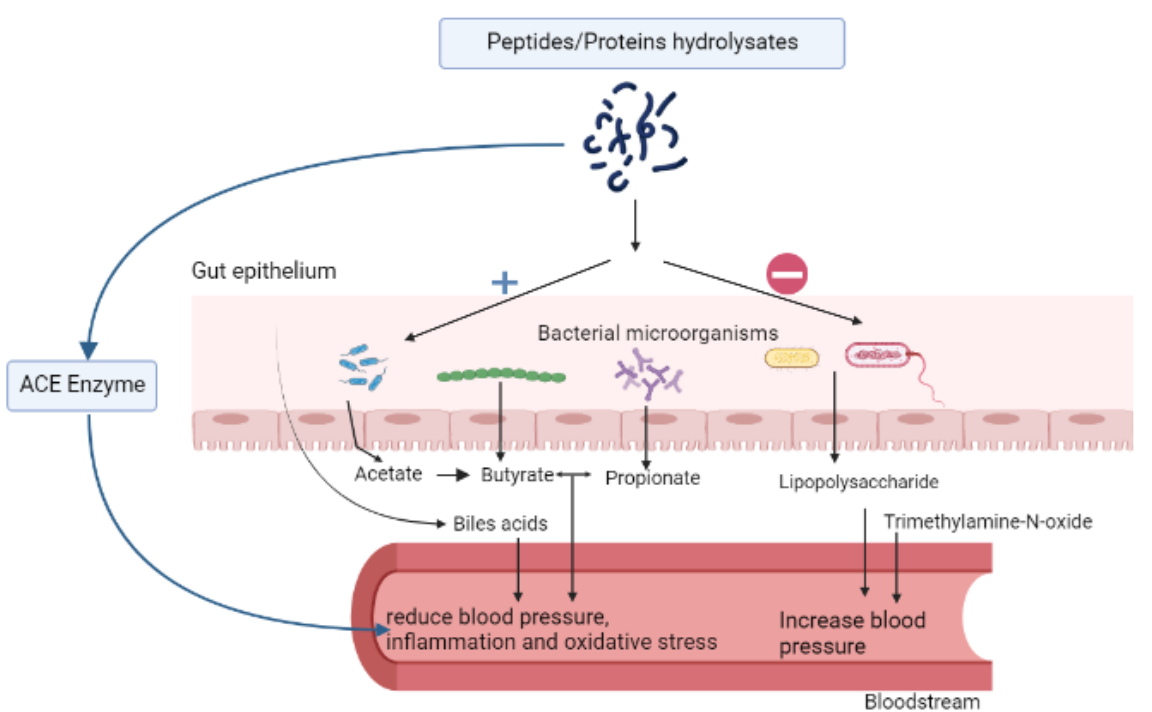
Figure 1. Effect of food peptides on hypertension via the regulation of the gut microbiota short-chain fatty acids, bile acids, angiotensin-converting enzyme, and pro-inflammatory markers.